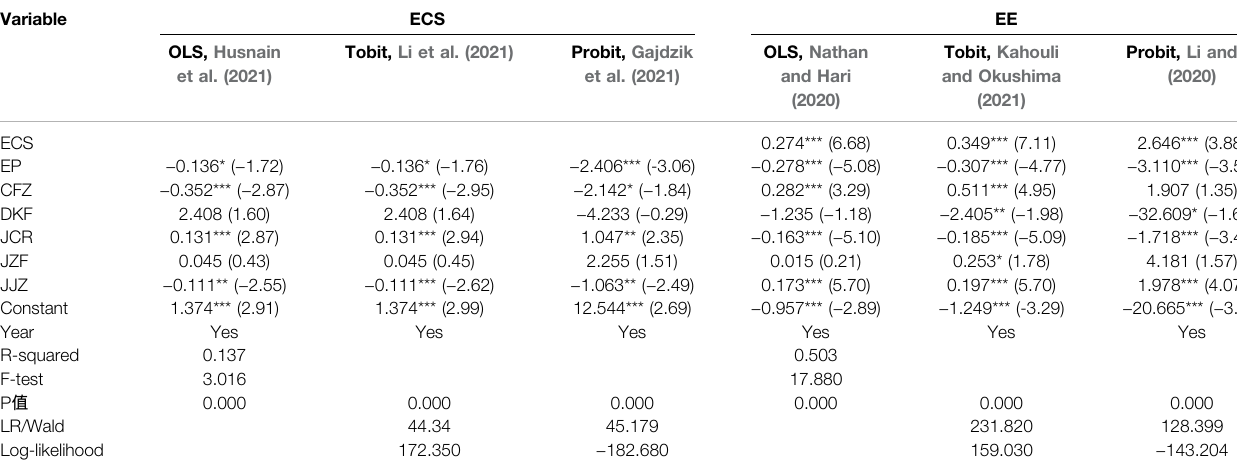
TABLE 6 | Regression results of mediating effect.